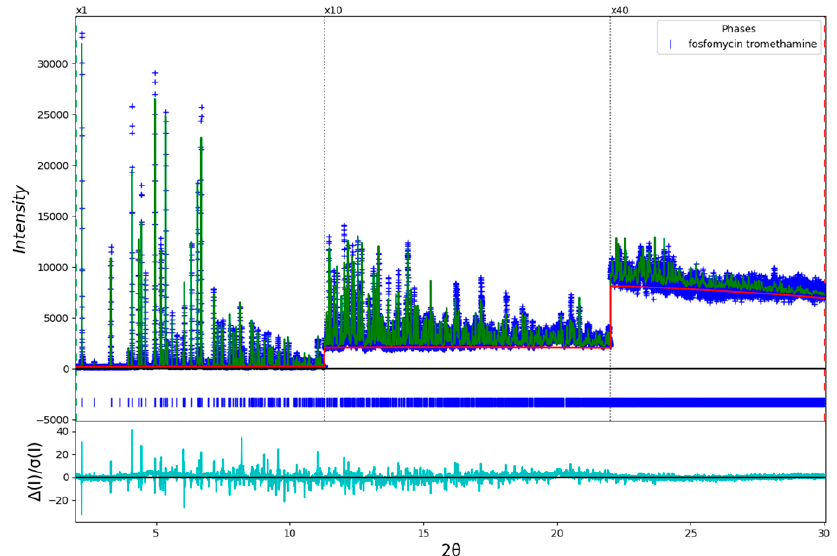
Figure 8. The Rietveld plot for the refinement of fosfomycin tromethamine. The blue crosses represent the observed data points, and the green line is the calculated pattern. The cyan curve is the normalized error plot. The vertical scale has been multiplied by a factor of 10 × for 2 θ > 11.3, and by a factor of 40 × for 2 θ > 22.0 ° .